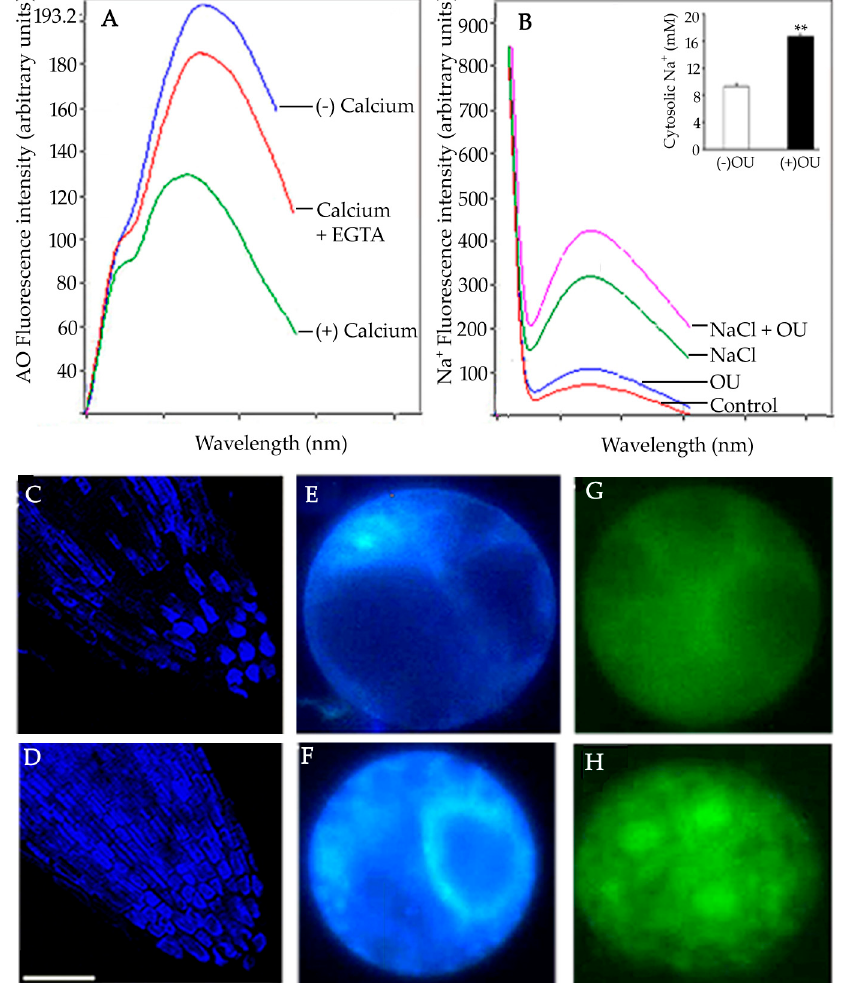
Figure 4. ( A ) Calcium-mediated inhibition of OU-sensitive ATPase activity and its subsequent recovery by EGTA. ( B ) Effect of ouabain (OU) on (Na + ) cyt in salt-stressed sunflower seedling roots. ( C ) Confocal laser scanning microscopic (CLSM) localization of salt stress-induced activity of OU-sensitive ATPase in two-day-old sunflower seedling root tips and ( D ) enhanced fluorescence obtained after simultaneous treatment with exogenous Ca 2+ (10 mM) and EGTA (5 mM). Scale bar = 75 µ M. ( E ) Subcellular localization of OU-sensitive ATPase from salt stress-induced seedling root protoplasts shows the distribution of the enzyme in the cytoplasmic vesicles and plasma membrane. ( F ) Enhanced enzyme activity induced by exogenous Ca 2+ (10 mM) and EGTA (5 mM) treatment is evident in the nuclear membrane. ( G ) Effect of ouabain on Na + accumulation in root protoplasts obtained from salt-stressed sunflower seedlings grown in the absence and ( H ) presence of ouabain [85].